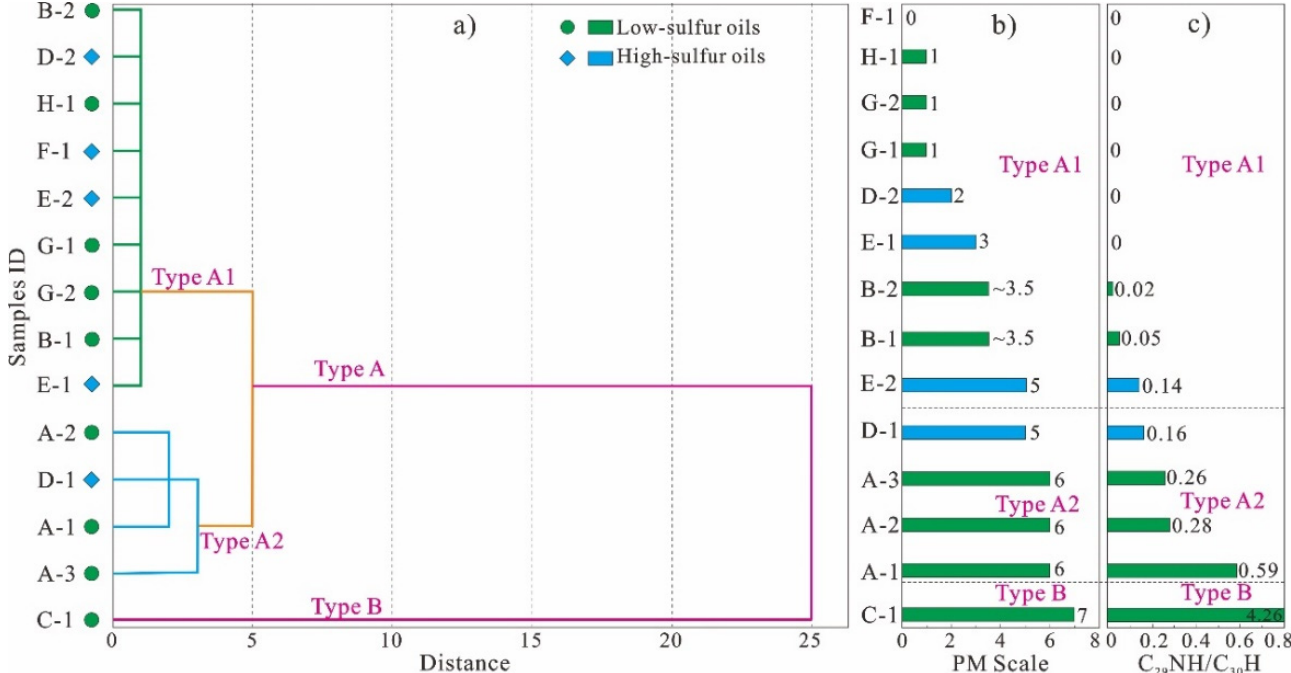
Figure 10. Dendrogram showing cluster analysis of the concentrations of Mg, Ca, Mn, Fe, Be, Sc, Rb, Sr, Zr, Pb, Th, and U ( a ), and histograms of PM Scale ( b ) and C 29 NH/C 30 H ( c ).